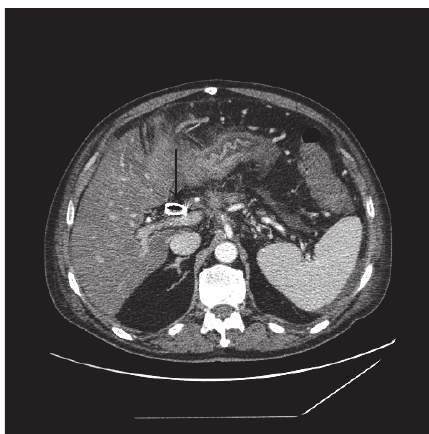
Figure 3: Abdominal contrast-enhanced CT, axial plane. Stented common bile duct is intimately close to the portal vein causing its minor